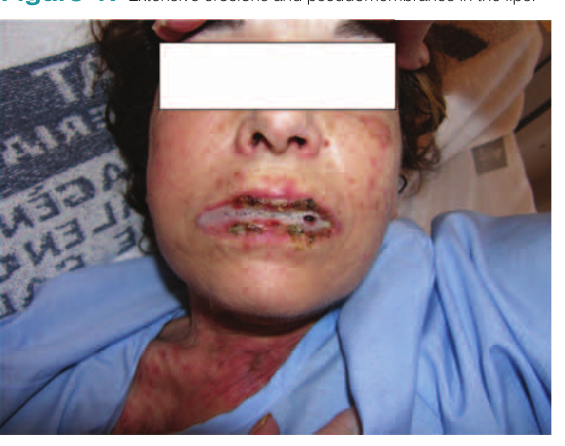
Figure 1. E xtensive erosions and p seudomembranes in the lips.